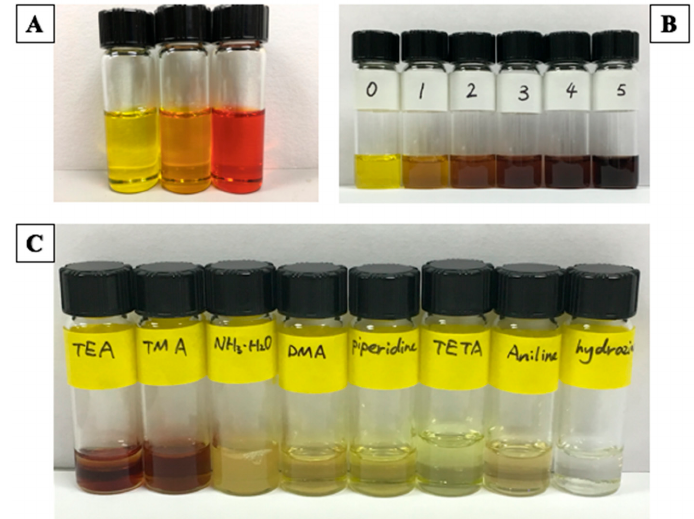
Figure 2. ( A ) Color of quinoxaline derivatives 5a , 5b , and 5c (from left to right; 10 μ M in DMSO) doped with p -TsOH (5000:1 acid:dye molar ratio). ( B ) Color of 20 μ M cinnamil 3a in DMSO with the addition of tetrabutylammonium hydroxide (TBAH): 0 = no TBAH, 1 = 0.3 µ mol